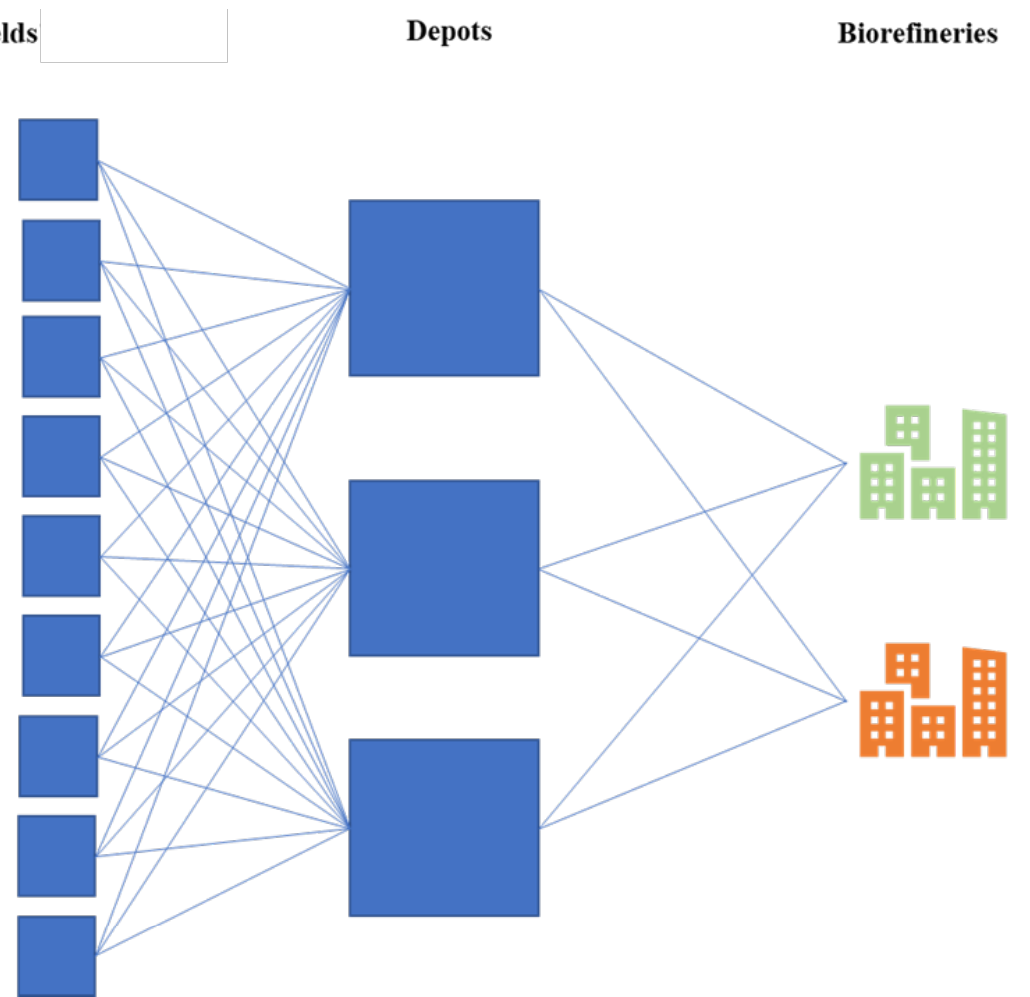
Figure 1. Schematic representation of the supply system.